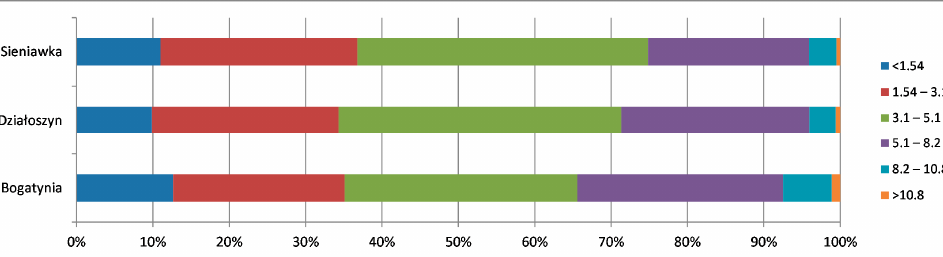
Figure10. Thefrequencyofwindspeedsinspecificrangesinselectedtownsin2018(source: own study).